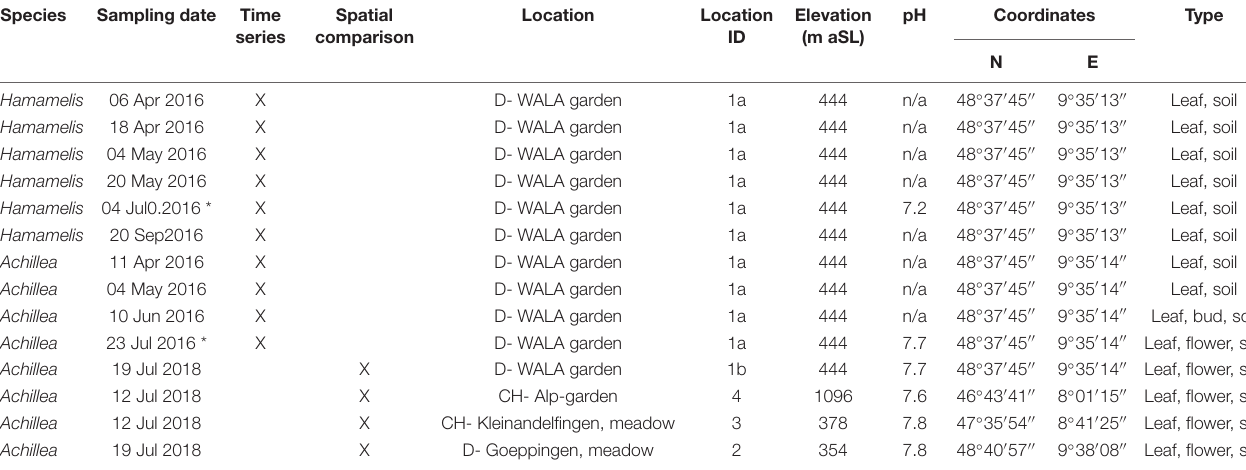
Type indicates plant compartment and soil sampled. Time series and spatial comparison highlight the samples used for the seasonal or spatial comparison. Samples of both plants in July 2016 were used for direct comparison and are marked with *.